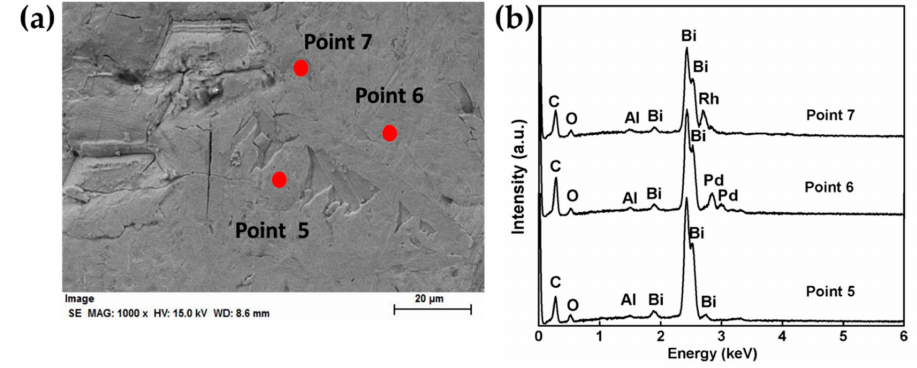
Figure 5. ( a ) FE-SEM image and ( b ) EDS spectra of point analysis on the recovered Bi metal phase separated from the heat-treated borosilicate glass in batch 2.